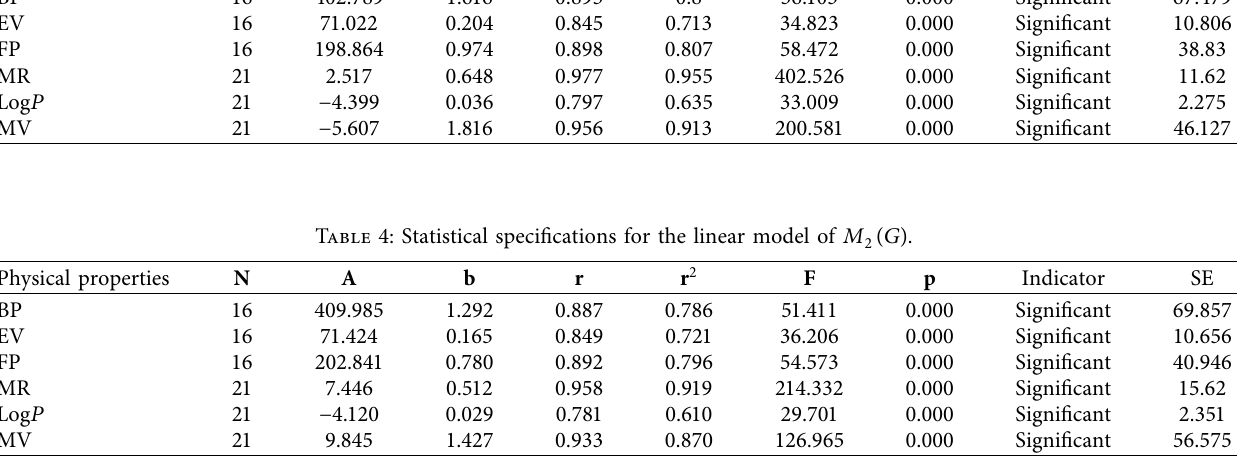
Table 3: Statistical specifications for the linear model of M